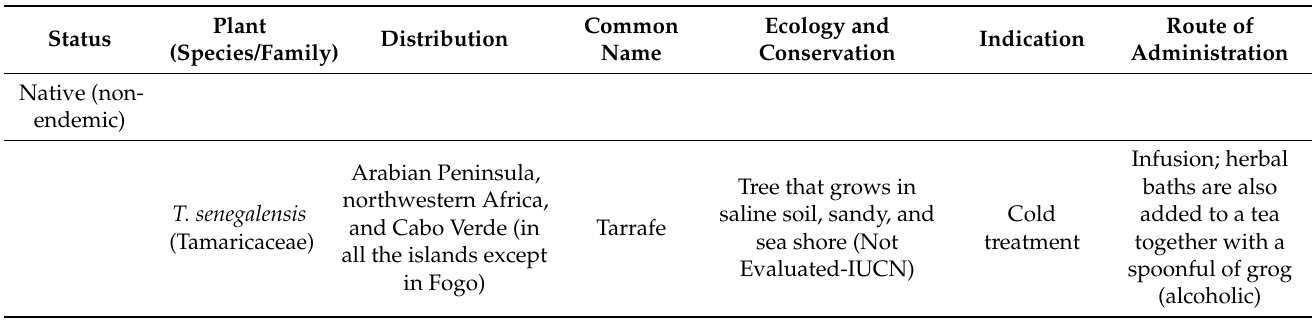
Table 1. Characterization of the plant species under study and their use in traditional medicine in Cabo